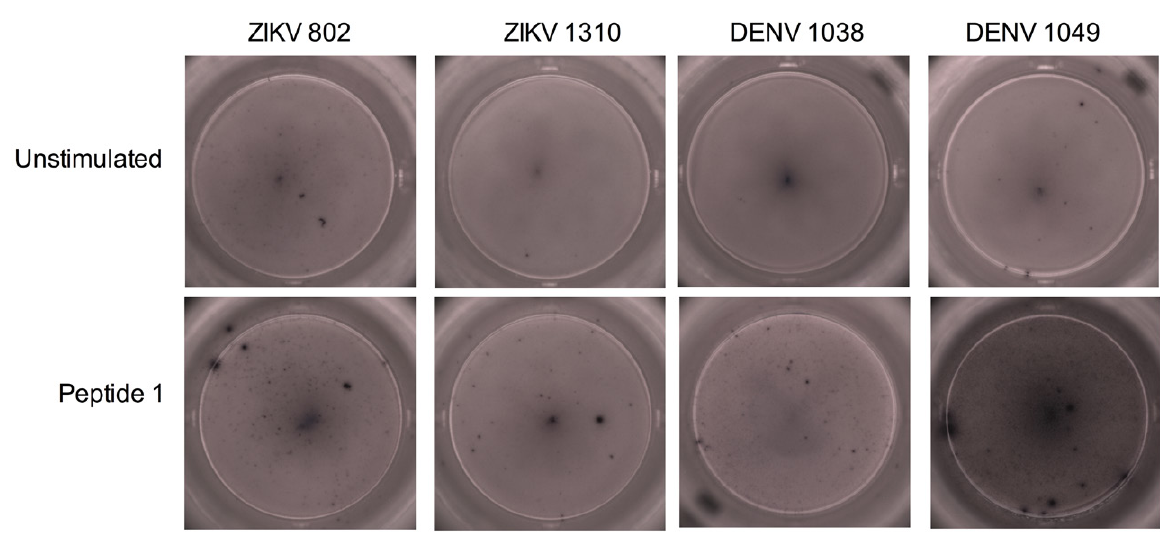
Supplementary Figure 1. IFNgamma ELISPOT results for unstimulated PBMCs (top row) or stimulated with peptide 1 (lower row).